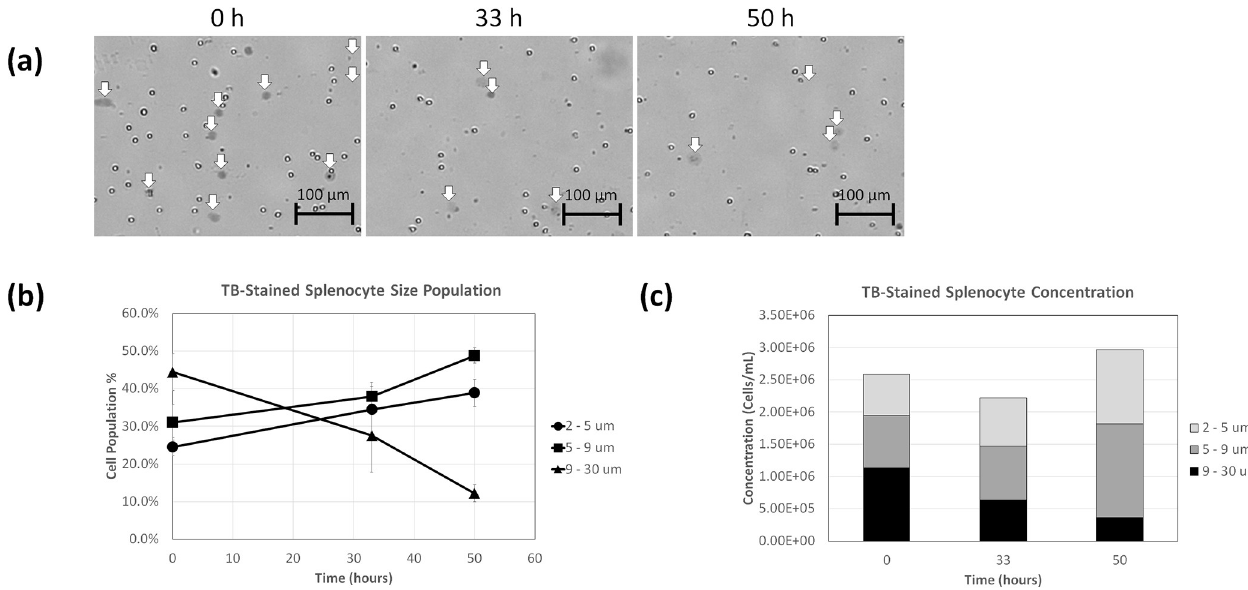
Fig 5. Time-course morphological analysis of TB-stained mouse splenocytes. (a) Bright field images of TB-stained mouse splenocytes acquired by the Vision 5X showing diffuse objects. (b) Time-dependent size populations over 50 h, showing increase in diffuse objects. (c) Concentration changes for different size populations over time.